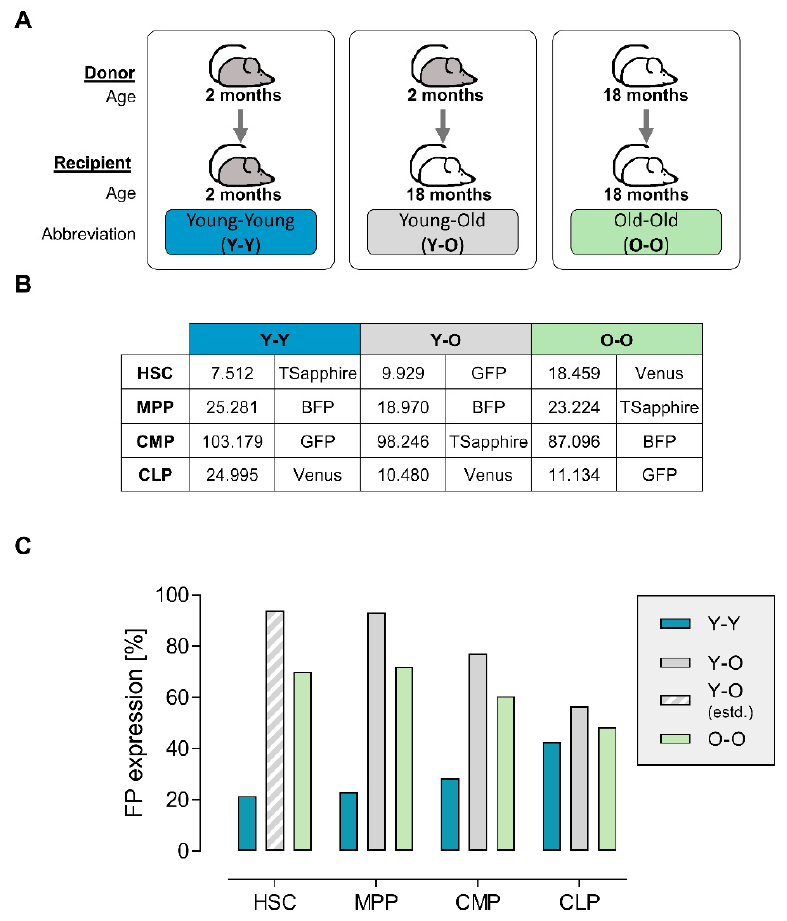
Figure 1. Experimental groups, sorted cell numbers, and transduction efficiencies. ( A ) The experimental groups were set up as follows: cells from 2-month-old male mice were used for transplantation into 2-month-old female recipients (blue: Y-Y), cells taken from young donors (18 months old) were transplanted into old recipients (2 months old, grey: Y-O), and finally cells from old donors were transplanted into old (both 18 months old) recipients (light green: O-O). ( B ) According to the marker profile, the cells were separated by FACS and transduced with lentiviral barcode vectors encoding the depicted fluorescent protein. Numbers depict the mean number of cells per animal obtained for each subpopulation after sorting. ( C ) Three days post transduction, transduction efficiencies for the four subpopulations were measured by flow cytometry of the respective fluorescent proteins. The value for the transduced HSCs in the Y-O experiment was estimated using Poisson distribution (grey striped bar). Blue bars represent the Y-Y experimental setting, grey bars represent the Y-O experimental setting, and light green bars represent the O-O experimental